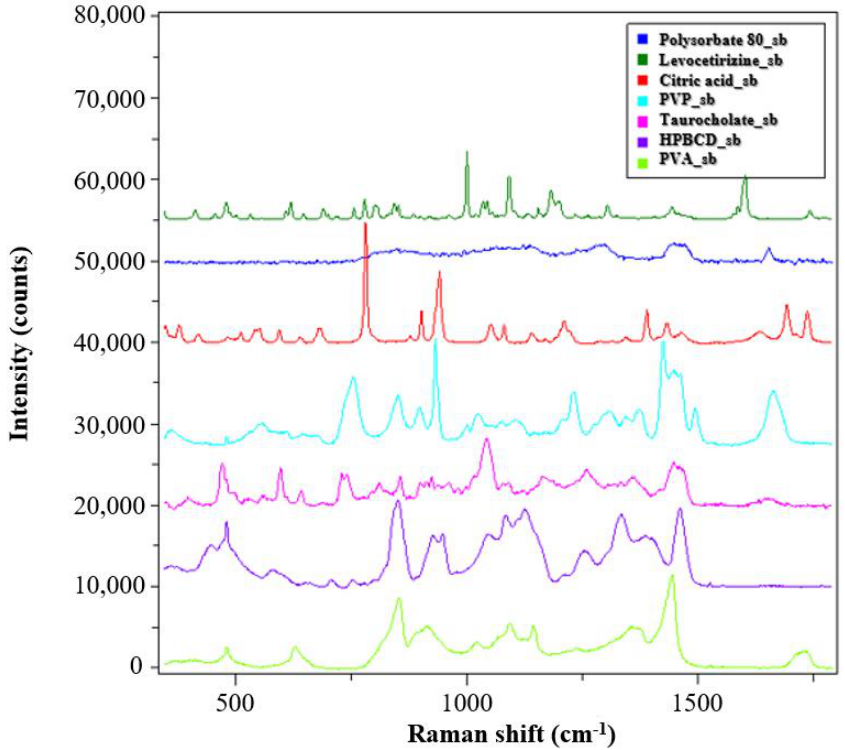
Figure 4. Raman spectra of the reference materials used for the fiber formation process.